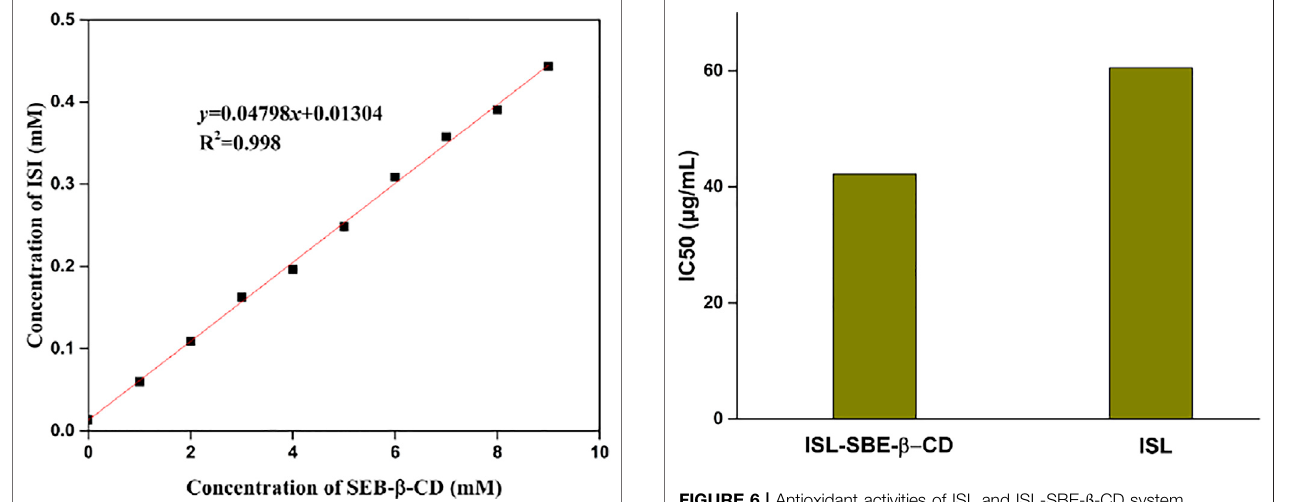
FIGURE 6 | Antioxidant activities of ISL and ISL-SBE- β -CD